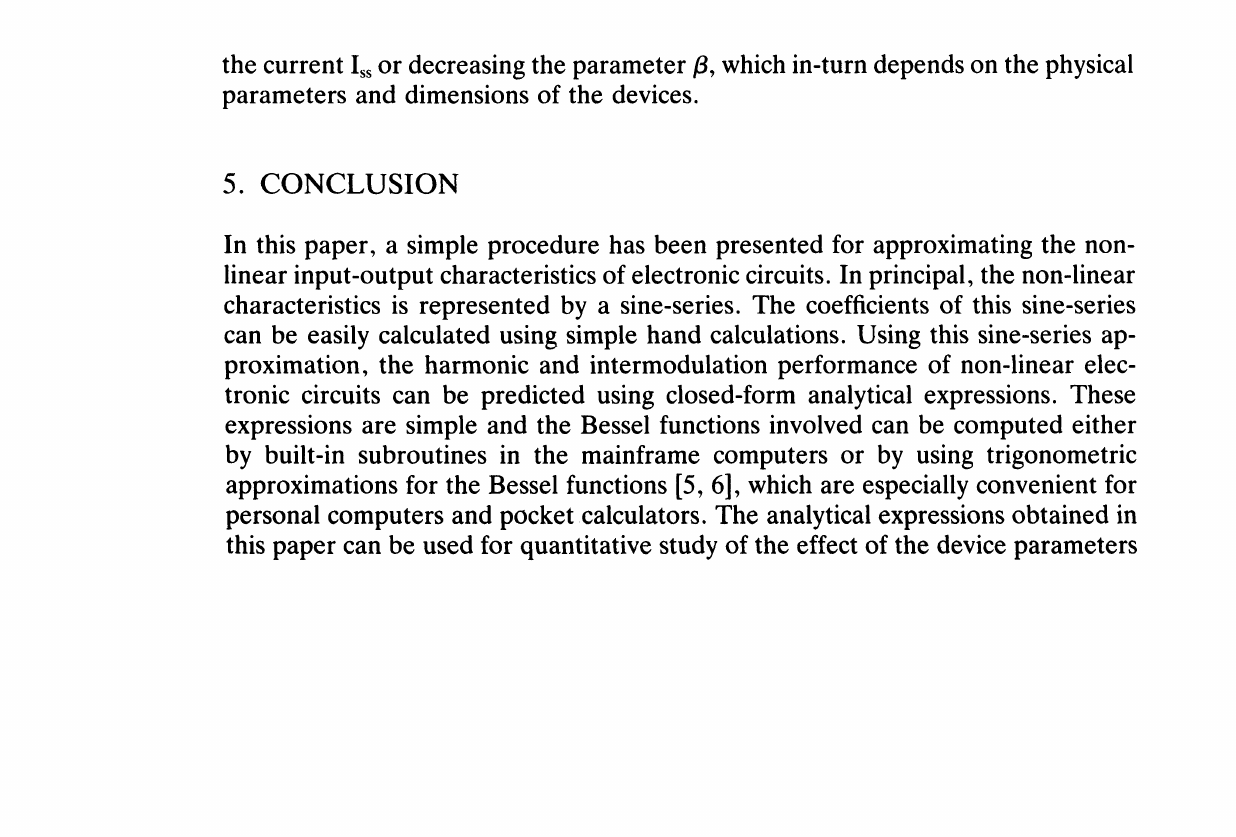
FIGURE 8 Input-output characteristic of the source-coupled amplifier of Fig.